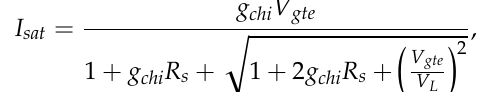
e ff ective, extrinsic saturation voltage, V sate = I sat / g ch ; I sat is the saturation current; g ch is the extrinsic channel conductance, g ch = g chi / (( 1 + g chi ( R s + R d ))) ; R s and R d are the source and drain